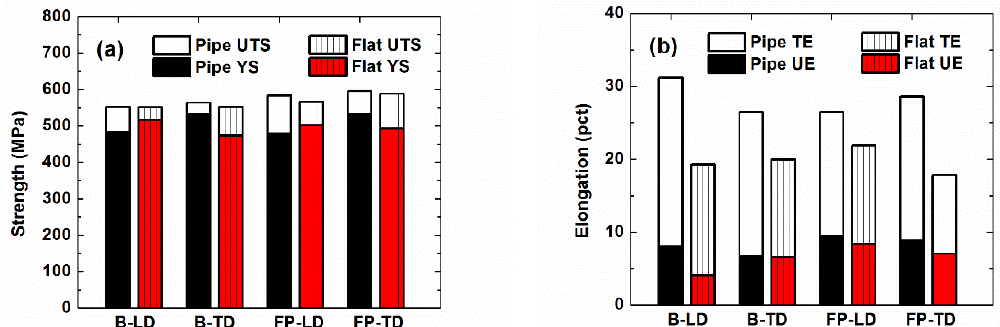
Figure 9. Average tensile properties for steel B and steel FP along the longitudinal direction (LD) or the transverse direction (TD) obtained from as-received pipe (Pipe) and flattened pipe (Flat) specimens. ( a ) Yield strength (YS) and tensile strength (UTS) and ( b ) uniform elongation (UE) and total elongation (TE).